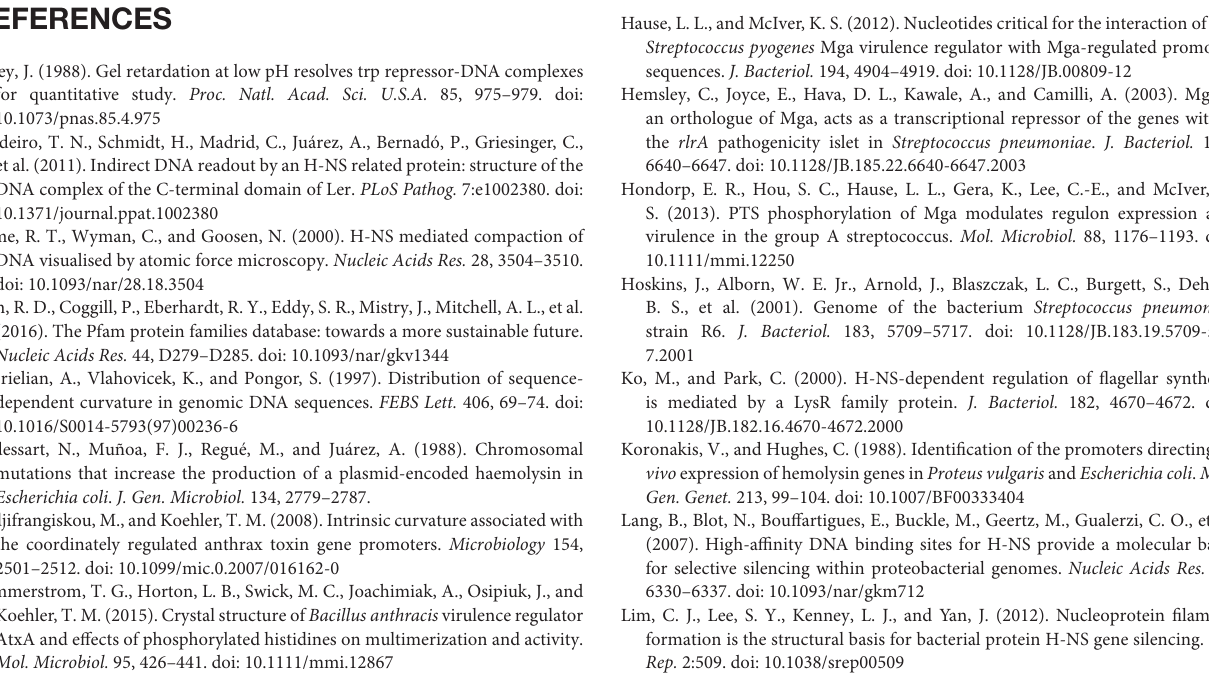
Supplementary Figure 1 | Binding of Mga Spn -His to the 290-bp hlyC DNA fragment. (A) EMSA. The 32 P-labeled hlyC DNA fragment (2 nM) was incubated with increasing concentrations of Mga Spn -His (20 to 180 nM). Free and bound DNAs were separated by native gel electrophoresis (5% polyacrylamide). Bands corresponding to free DNA (F) and to several protein-DNA complexes (C1, C2, C3, and C4) are indicated. (B) Affinity of Mga Spn -His for the 290-bp hlyC DNA fragment. The autoradiograph shown in A was scanned, and the percentage of free DNA was plotted against Mga Spn -His